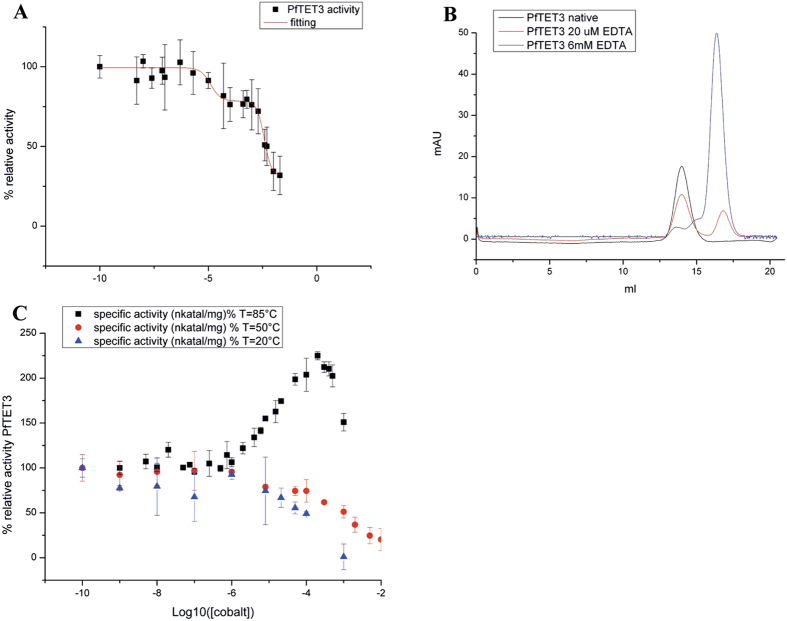
Enzymatic activity and oligomerization state of PfTET3 is modulated by M1.(A) EDTA titration of PfTET3 activity towards 5 mM Lys-pNa at T = 85 °C. Data are fitted by a bi-dose responsive curve from Origin 8.5 (red line). Error bars are standard deviations of three independent measurements. (B) Gel filtration (GF) profiles of PfTET3Zn heated at 85 °C in the absence of EDTA (black line, dodecamer), with 15 μM EDTA (red line, 60% dodecamer and 40% monomer from GF profile)) and with 6 mM EDTA (blue line, monomer). (C) Co2+ titration of PfTET3 activity towards 5 mM Lys-pNa at T = 85 °C (black squares), T = 50 °C (red squares) and T = 20 °C (blue squares). Co2+ enhances the PfTET3 activity only at 85 °C.